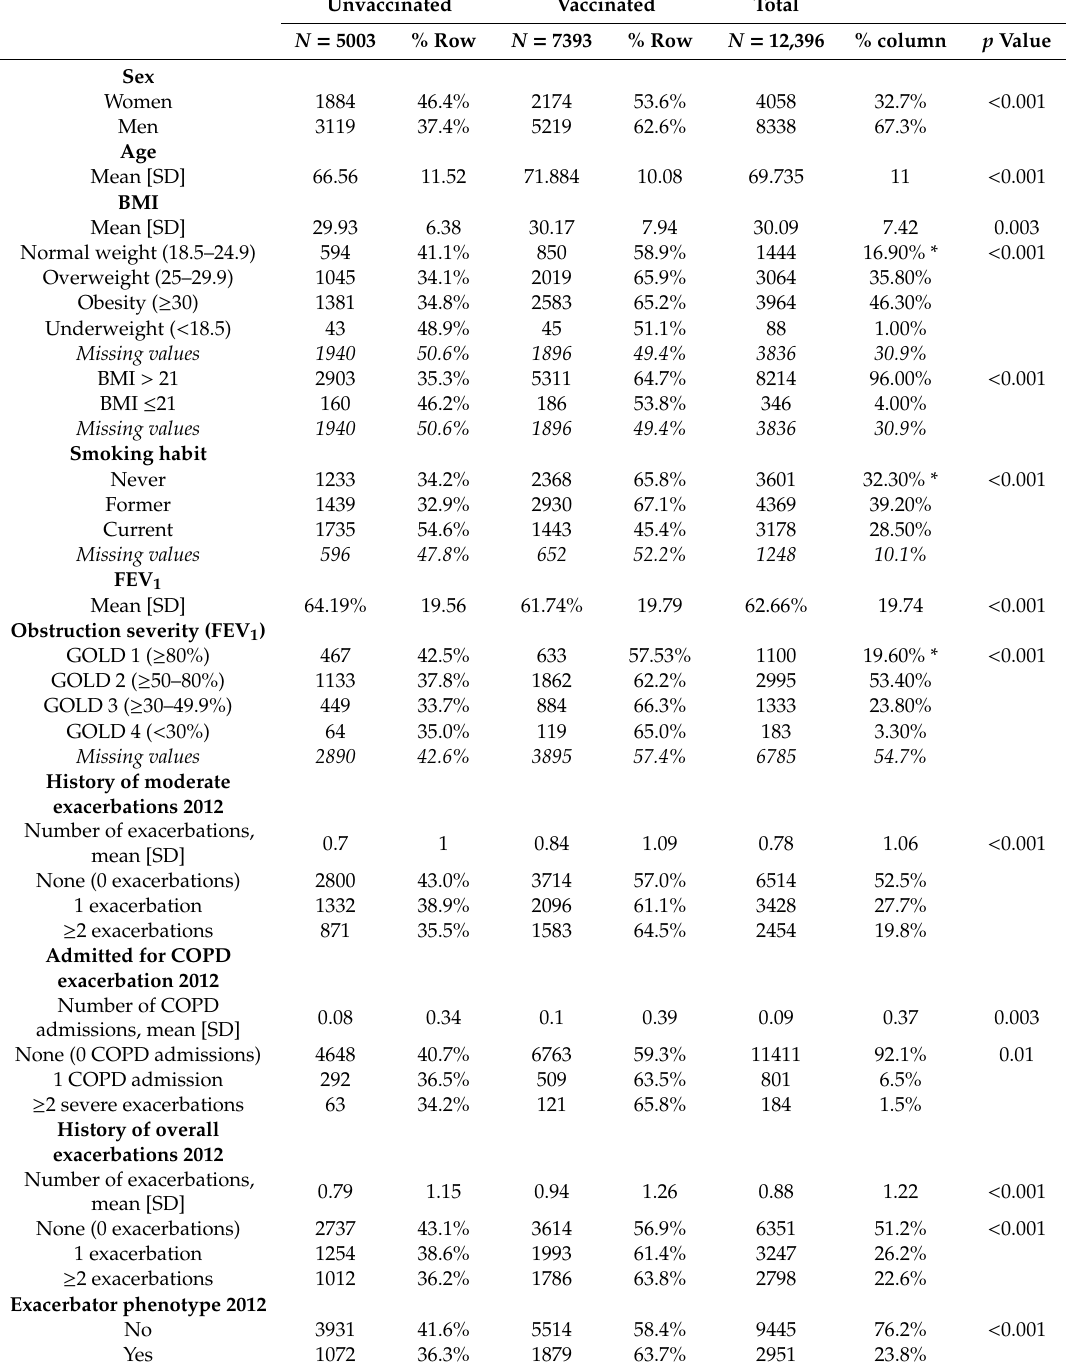
Table 1. Main sociodemographic and clinical variables in relation to influenza vaccination during 2012 / 2013 seasonal